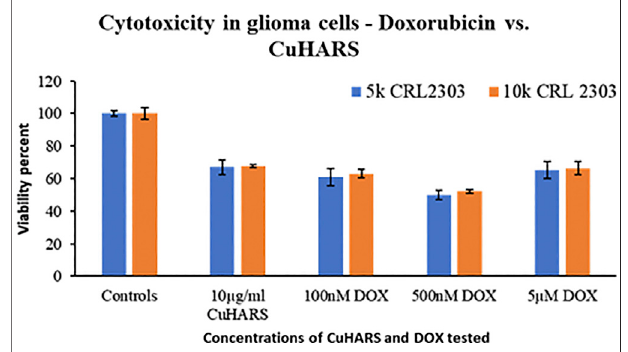
FIGURE 10 | Comparison of the toxicity response of CuHARS and anti-cancer drug Doxorubicin (DOX), against glioma cells CRL2303, plated at 5,000 (5k) or 10,000 (10k) cells/well. Viability was calculated using MTT assay as described in methods, and data were normalized to control values,whichweresetto100%.Datarepresentaverageoverthreeexperiments ( N (cid:2) 3) with triplicated wells ( n (cid:2) 3). The error bars represent SEM